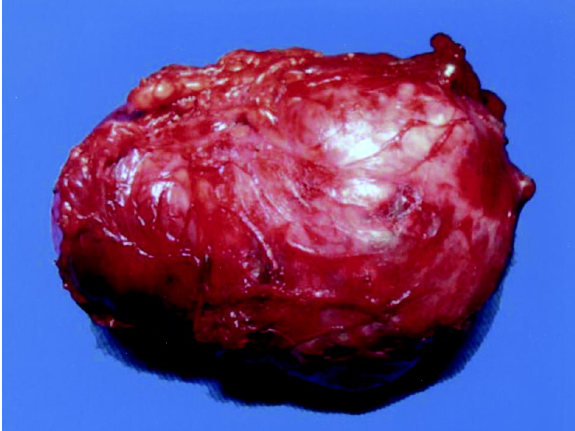
Figure 4 – Post-chemotherapy retroperitoneal residual mass. Surgical specimen.